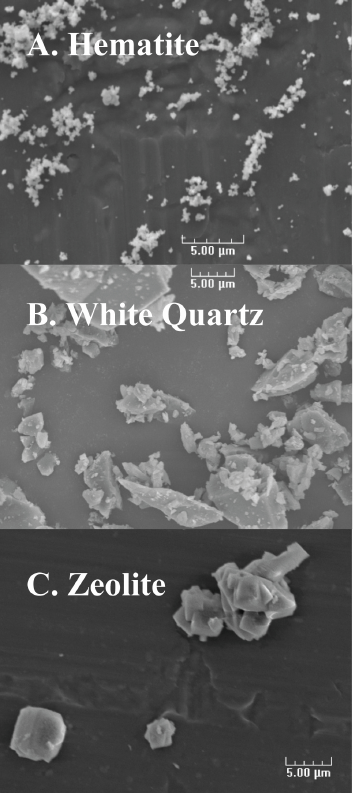
Fig. 8. SEM images of hematite, quartz, and zeolite particles are shown in (A) , (B) , and (C) ,